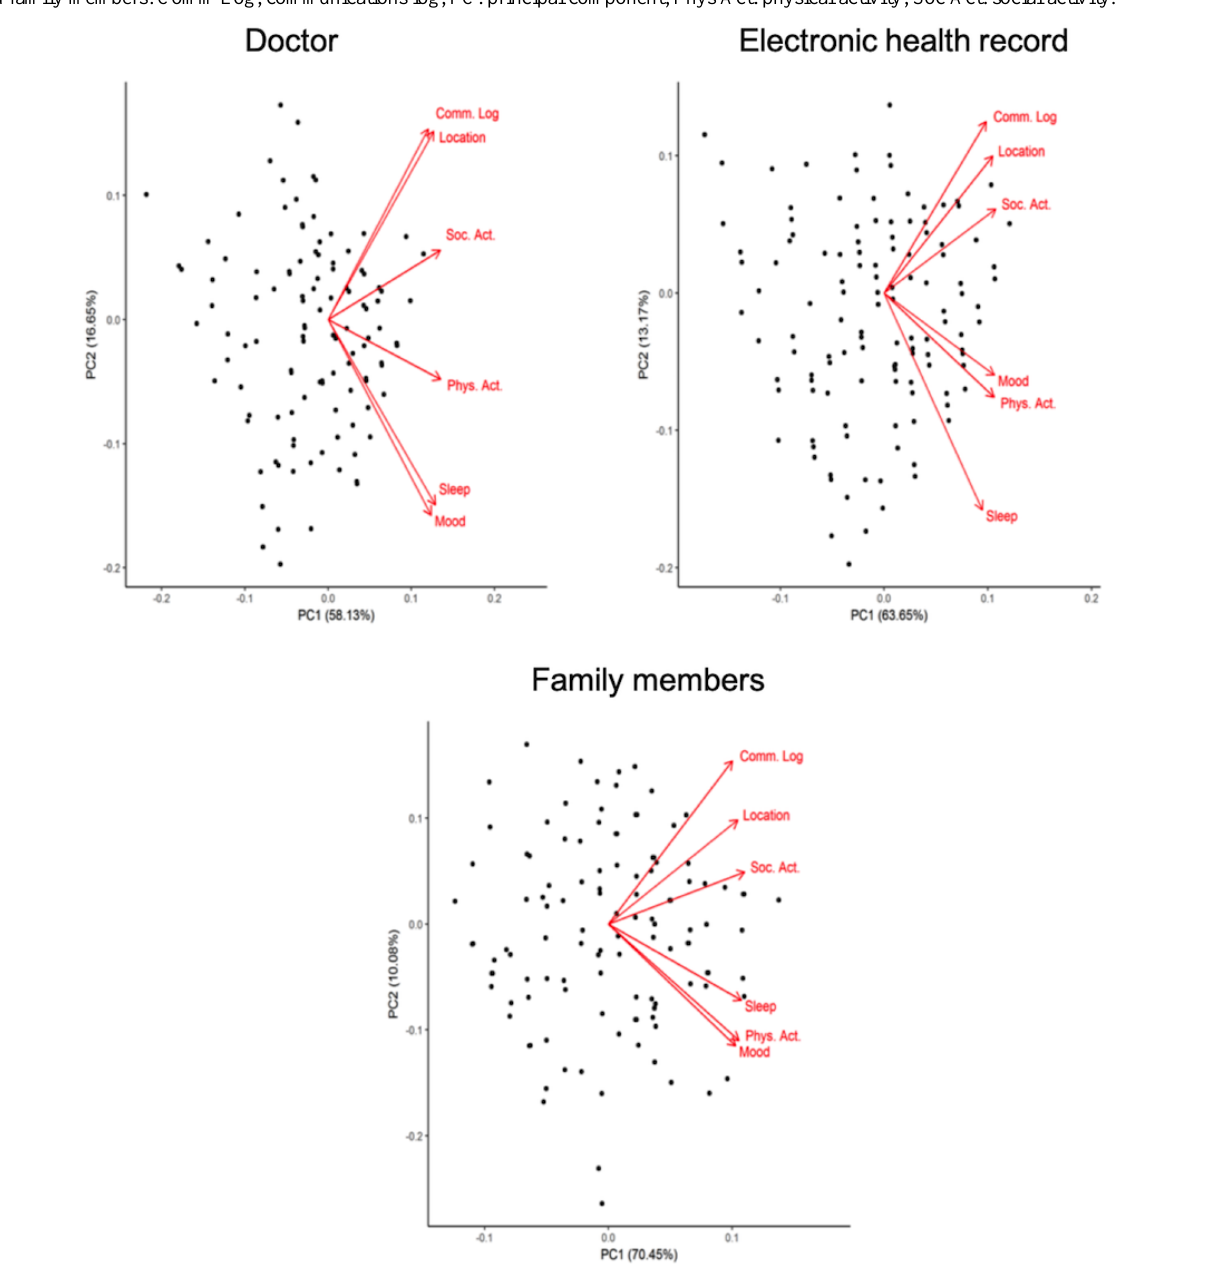
Figure 1. Principal component analysis of participant comfort with sharing data from six different sensors with their doctor, electronic health record, and family members. Comm Log; communications log; PC: principal component; Phys Act: physical activity; Soc Act: social activity.